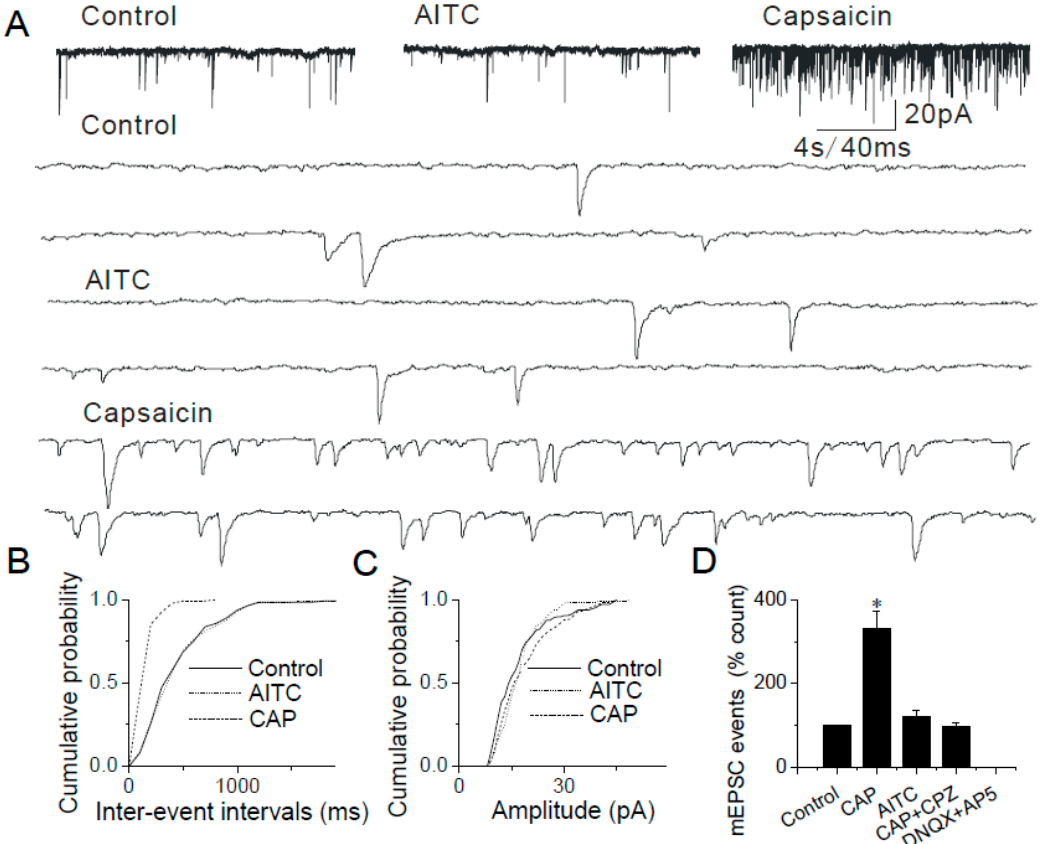
Figure 10. AITC does not induce enhancement of synaptic transmission in the TRPA1 knockout mice. ( A ) Application of AITC (200 µ M) does not increases the frequency of mEPSC in the TRPA1 knockout mice (105.21 ± 12.23%, n = 15, p > 0.05); whereas, capsaicin increase the frequency of mEPSC significantly (309 ± 42%, n = 7, p < 0.05); The synaptic events are shown in higher time resolution below. ( B ) Cumulative probability plot showing decreased interevent intervals representing increased frequency of mEPSCs mediated by capsaicin (i.e., CAP; p < 0.0001, KS test), but no change of interevent intervals mediated by AITC. ( C ) There was no change in the amplitude in all three groups. ( D ) Summary graph showing only capsaicin-mediated increases but no AITC mediated changes in the frequency of mEPSCs (* p < 0.05). The asterisk (*) represents p < 0.05 as compared to control .